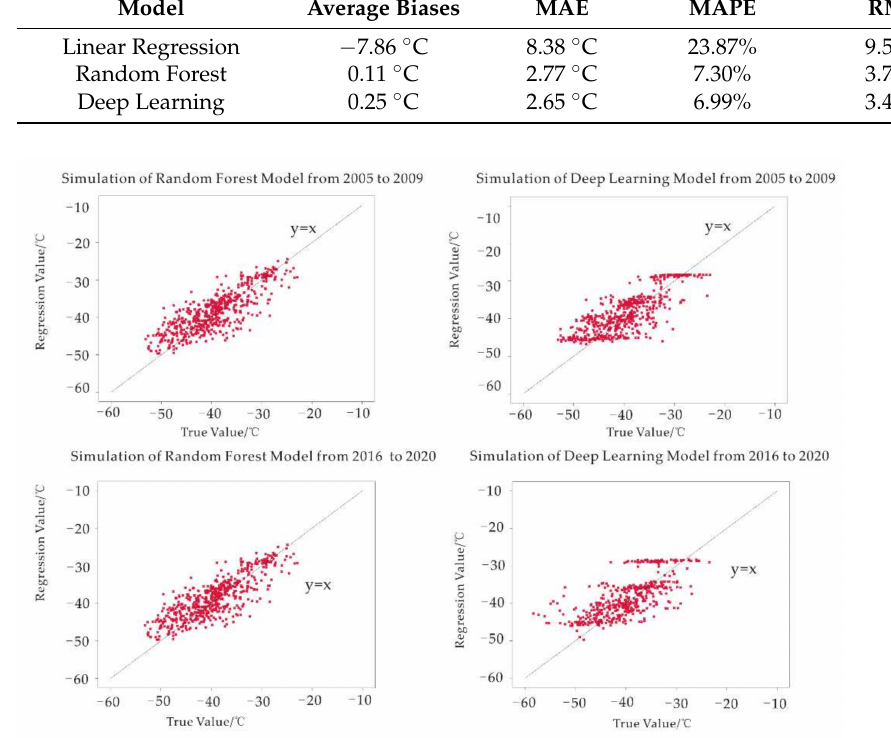
Figure 9. Comparison of the deviation degree between the simulation and the true